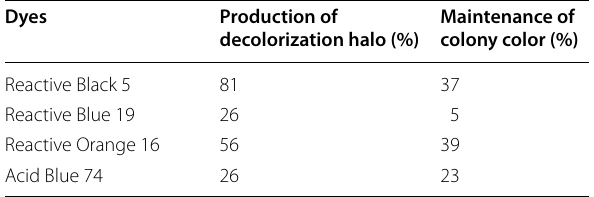
Table 2 Comparison through the use of different dyes of the percentages of cold-adapted yeasts producing a decolorization halo and maintaining the original color of the colony Dyes Production of Maintenance of decolorization halo (%) colony color